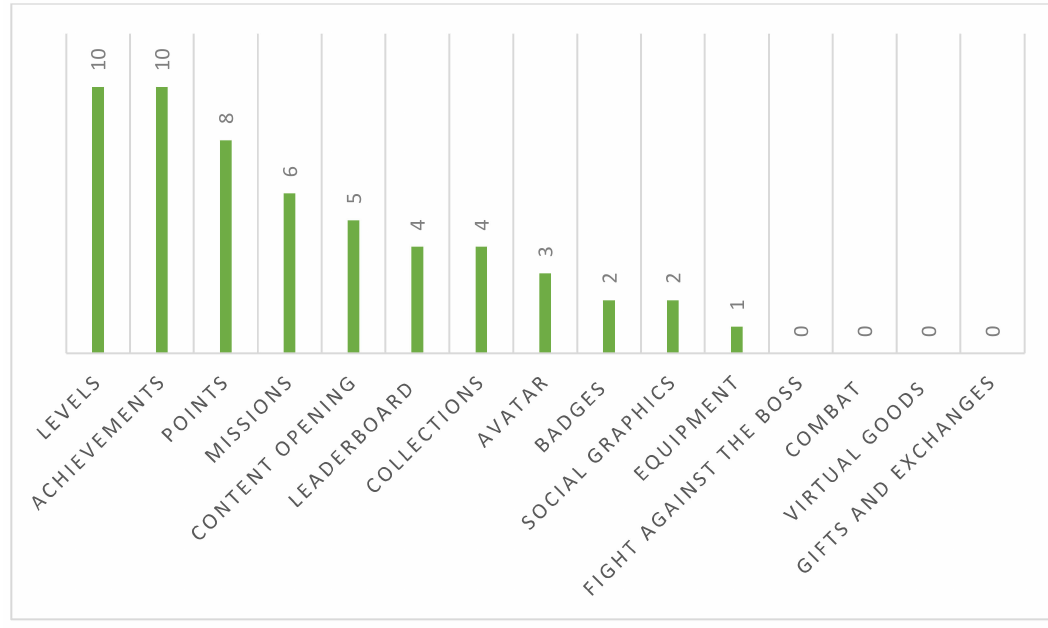
Figure 2. Components according to gamification